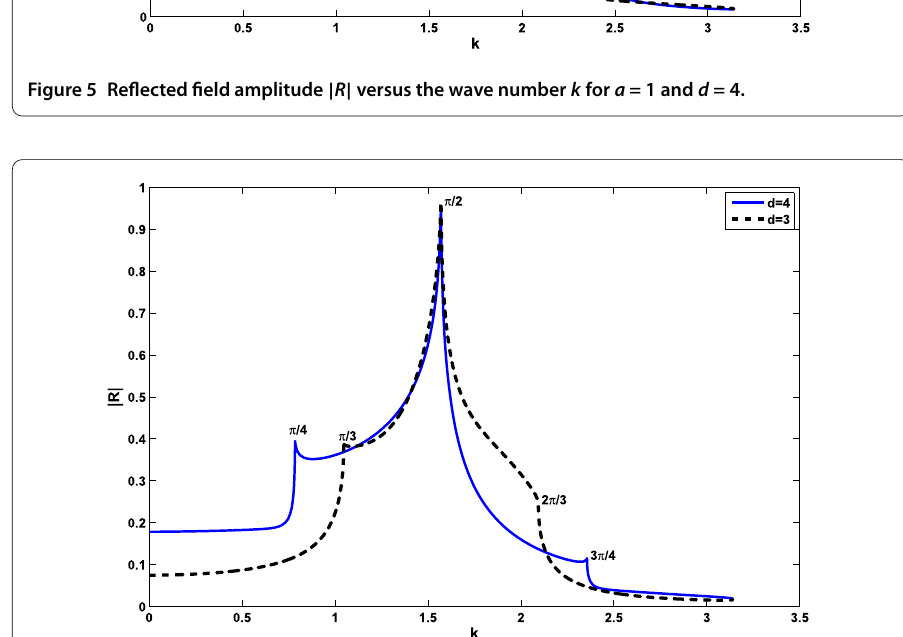
Figure 6 Reflected field amplitude | R | versus the wave number k for a = 1 and b =